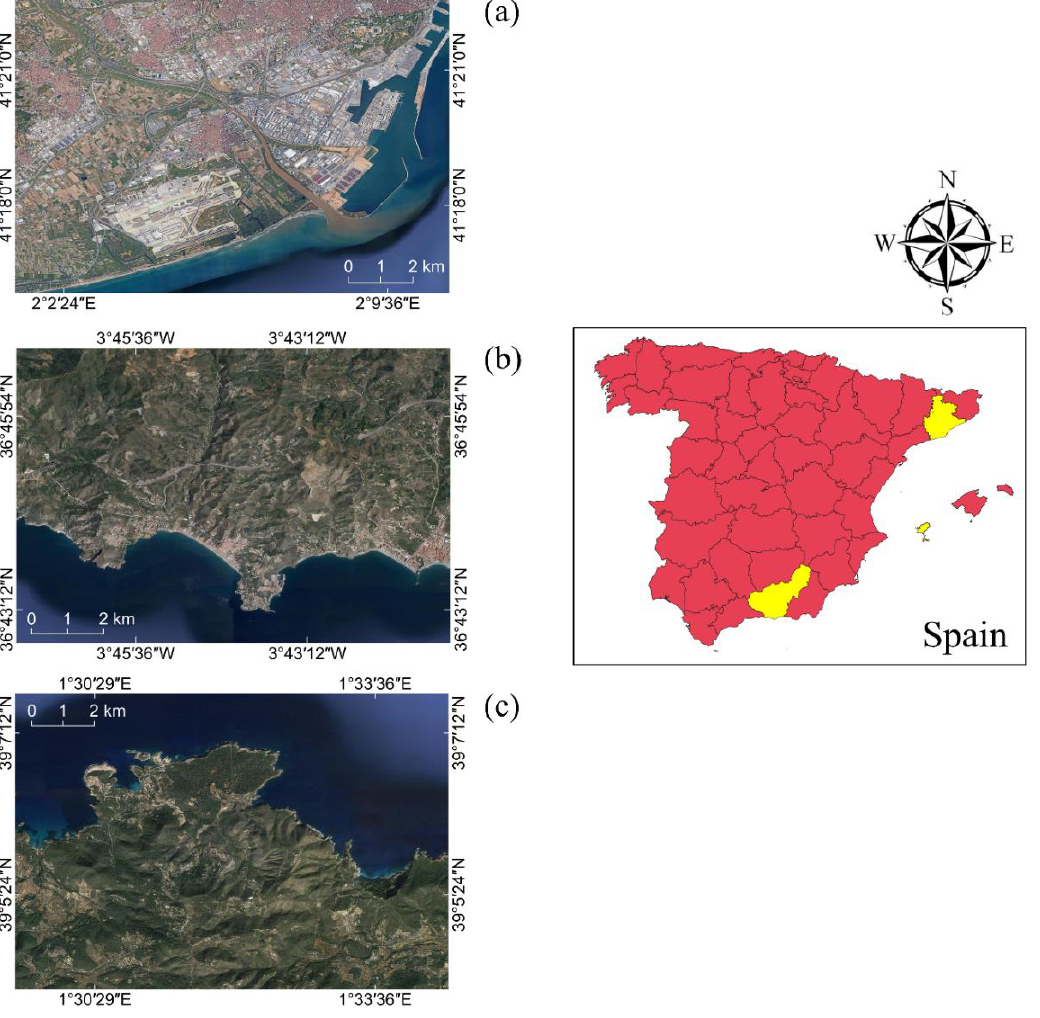
Figure 1. Three study areas in Spain: ( a ) Barcelona, ( b ) Granada, and ( c )